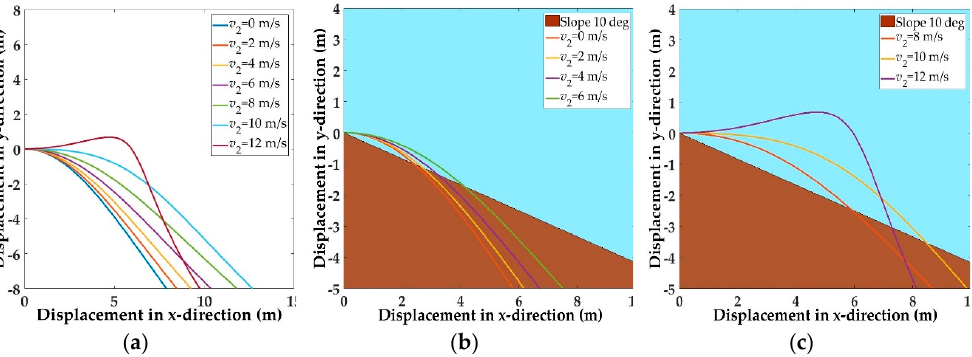
Figure 4. Trajectories of Anchiornis running at a speed of 5 m/s and 𝜽 = 10°: ( a ) 𝒗 𝟐 changes from 0 to 12 m/s; ( b ) 𝒗 𝟐 changes from 0 to 6 m/s; ( c ) 𝒗 𝟐 changes from 8 to 12 m/s.